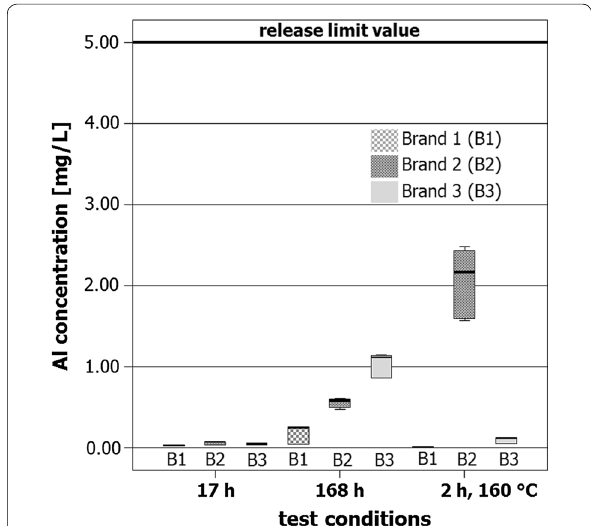
Fig. 5 Box plots of the aluminum concentrations in water samples after contact with brands 1, 2, and 3 of aluminum pans after 17 h con‑ tact at room temperature (17 h), 168 h contact at room temperature (168 h) and 2 h contact at 160 °C in the drying oven (2 h, 160 °C). The heavy line at 5.00 mg/L denotes the SRL